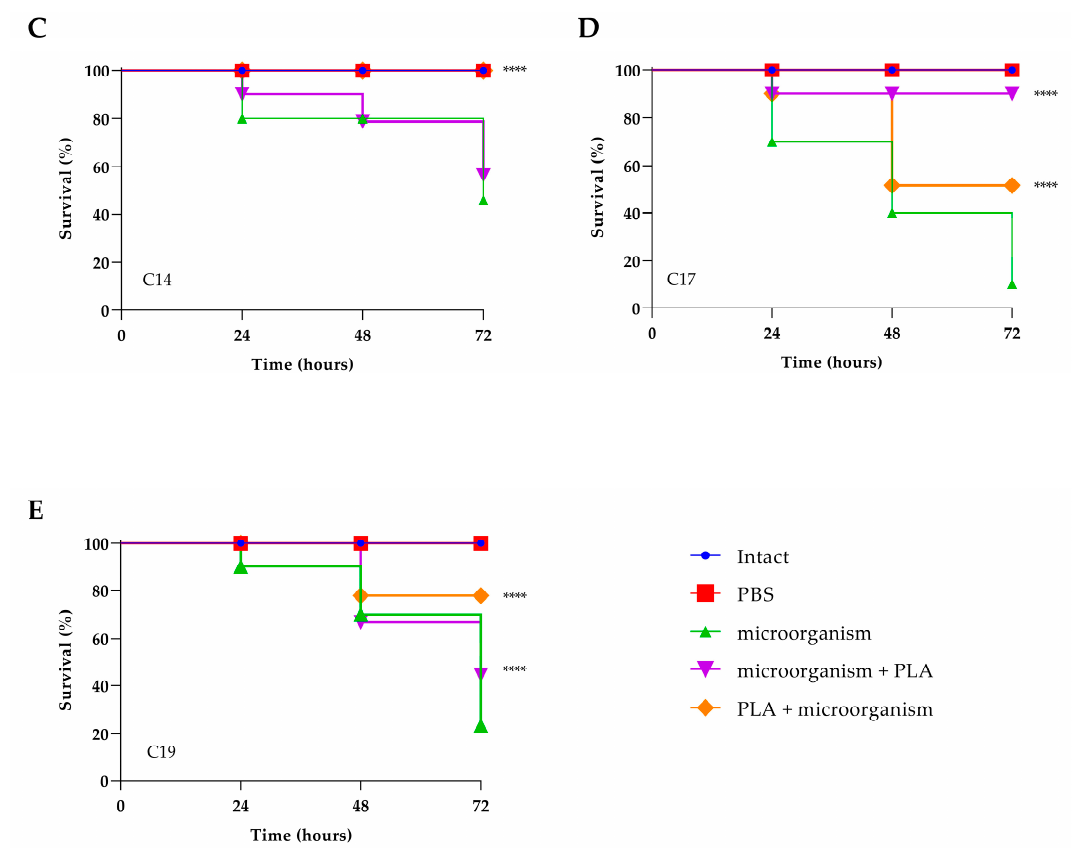
Figure 8. Kaplan–Meier plots of survival curves of G. mellonella larvae infected with C. albicans ATCC90028 ( A ), C7 ( B ), C14 ( C ), C17 ( D ), and C19 ( E ). The concentration of microorganisms was 1 × 10 6 CFU/larva. All groups were treated with 2.5 mg mL − 1 PLA before or after infection. All groups were compared with control (infected larvae). In all panels, survival curves of intact larvae and larvae injected with PBS are reported. **** represents p -value < 0.001 (Tukey’s).